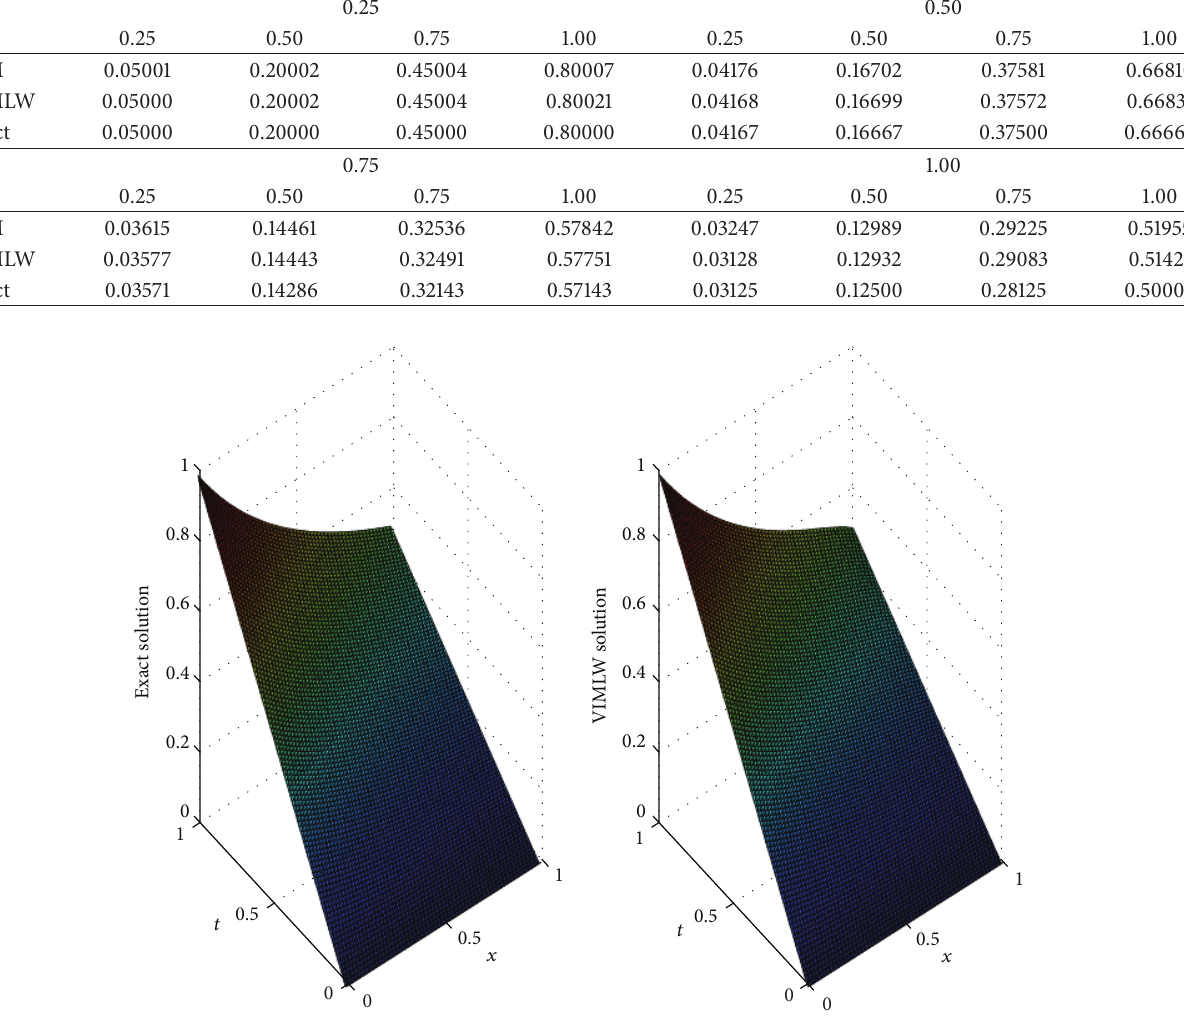
Figure 1: Exact solution and VIMLW approximate solution of Example